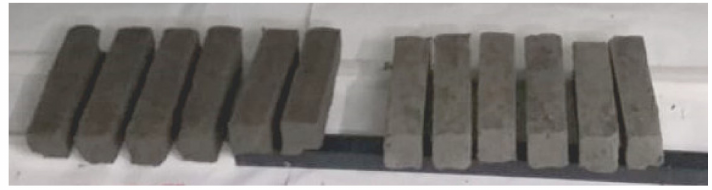
Figure 5. Alkali-activated SSS-FA pastes.